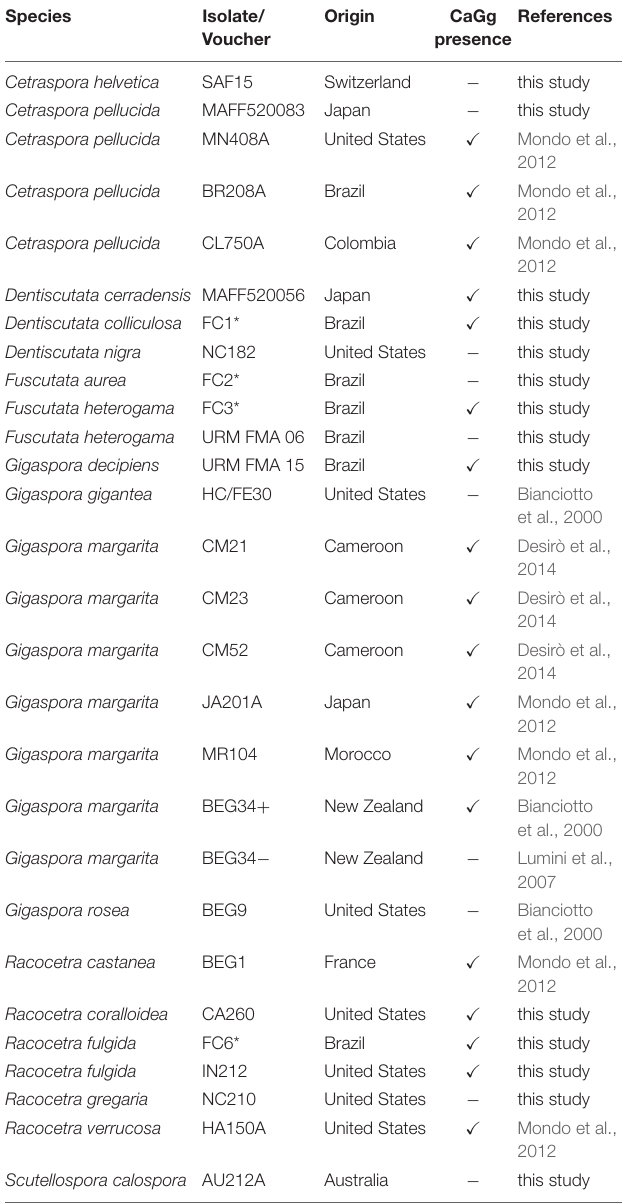
TABLE 2 | List of isolates used in the PCR screening for NRPS-PKS in